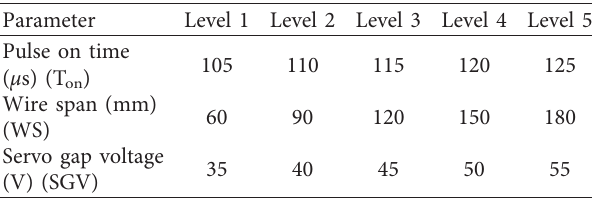
Table 2: Experimental parameters used for investigation.